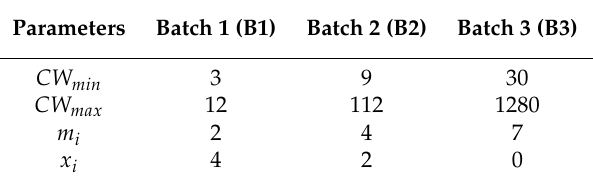
Table 4. Parameters used in numerical